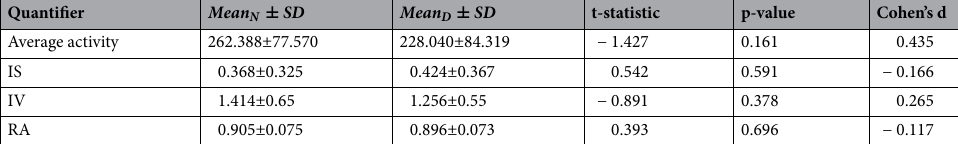
Table 3. Differences in means of traditional quantifiers of the actigraphy time series for the non-depressed ( n = 25 ) and depressed ( n = 21 ) groups. IS: Interdaily stability; IV: Intradaily variability; RA: Relative Amplitude; Mean N : Mean of the non-depressed group; Mean D : Mean of the depressed group; SD:standard deviation.